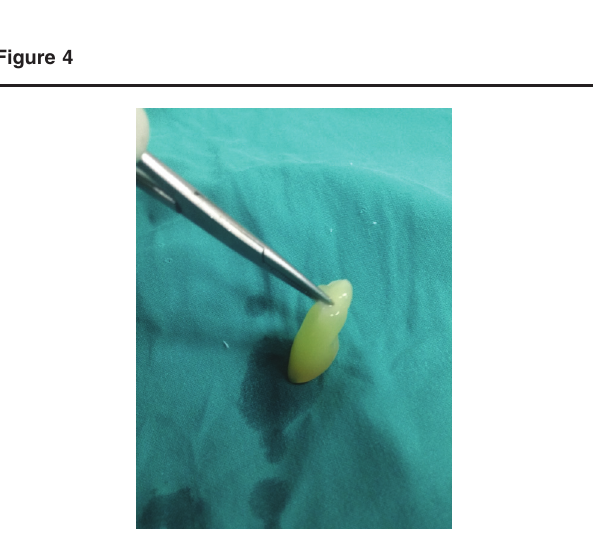
Intraoperative endoscopic view shows the graft is fitted into the perforation.